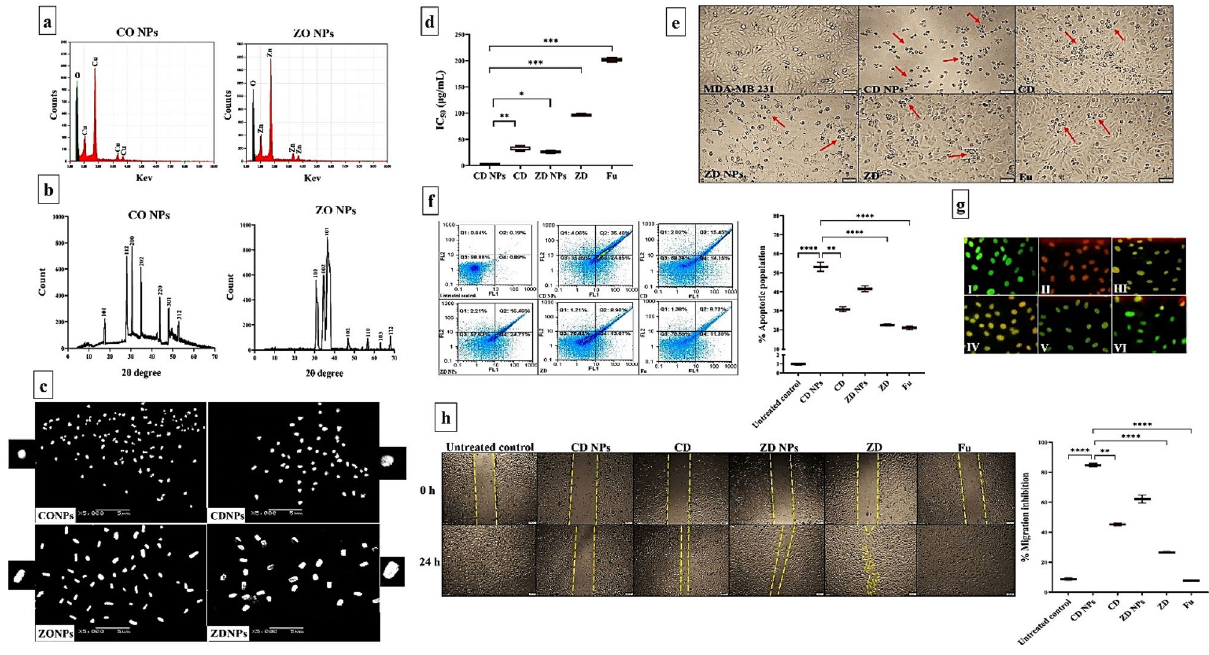
Figure 1. Characterization of the prepared NPs and anticancer impact on MDA-MB 231 cells. ( a ) Elemental charts of Cu and O in copper oxide (CO) NPs as well as Zn and O in zinc oxide (ZO) NPs using energy dispersive X-ray analysis (EDX). ( b ) X-ray diffractometer (XRD) patterns for CO NPs and ZO NPs. ( c ) scanning electron microscope images of CO NPs and ZO NPs as well as their corresponding nanocomplexes with diethyldithiocarbamate (CD NPs and ZD NPs, respectively) at magnification, × 5000; scale bar, 5 µm. For more declaration, individual nanoparticle of each prepared type was showed at maximum magnification. ( d ) MTT results in the term of IC 50 values of CD NPs, CD, ZD NPs, ZD, and 5-fluorouracil (Fu) with ( e ) morphological alterations of these treated MDA-MB 231 cells (Red arrows refer to apoptotic cells) compared to the untreated control cells. (Magnification, × 100; scale bar, 50 µm). ( f ) Apoptotic activity as illustrated by flow cytometry dot plots of the untreated MDA-MB 231 and CD NPs-, CD-, ZD NPs-, ZD-, and Fu-treated cells with the total percentage of apoptosis after staining with annexin V/propidium iodide as well as ( g ) fluorescence microscopic images for the untreated and treated MDA-MB 231 after incubation with acridine orange and ethidium bromide (Green, yellow and orange-red fluorescence reflect healthy, early apoptotic, and late apoptotic cell population, respectively) (Magnification, × 100; scale bar, 50 µm). ( h ) Anti-migration activity as showed by microscopic pictures of the wound area (yellow dashed line-labeled) in the untreated and treated MDA-MB 231 cells at 0 and 24 h (Magnification, × 40; scale bar, 200 µm) with the percentage of migration inhibition. Data are demonstrated as mean ± SEM. CD NPs were compared to other tested compounds, considering significantly different at p < 0.05*, < 0.01**, and <